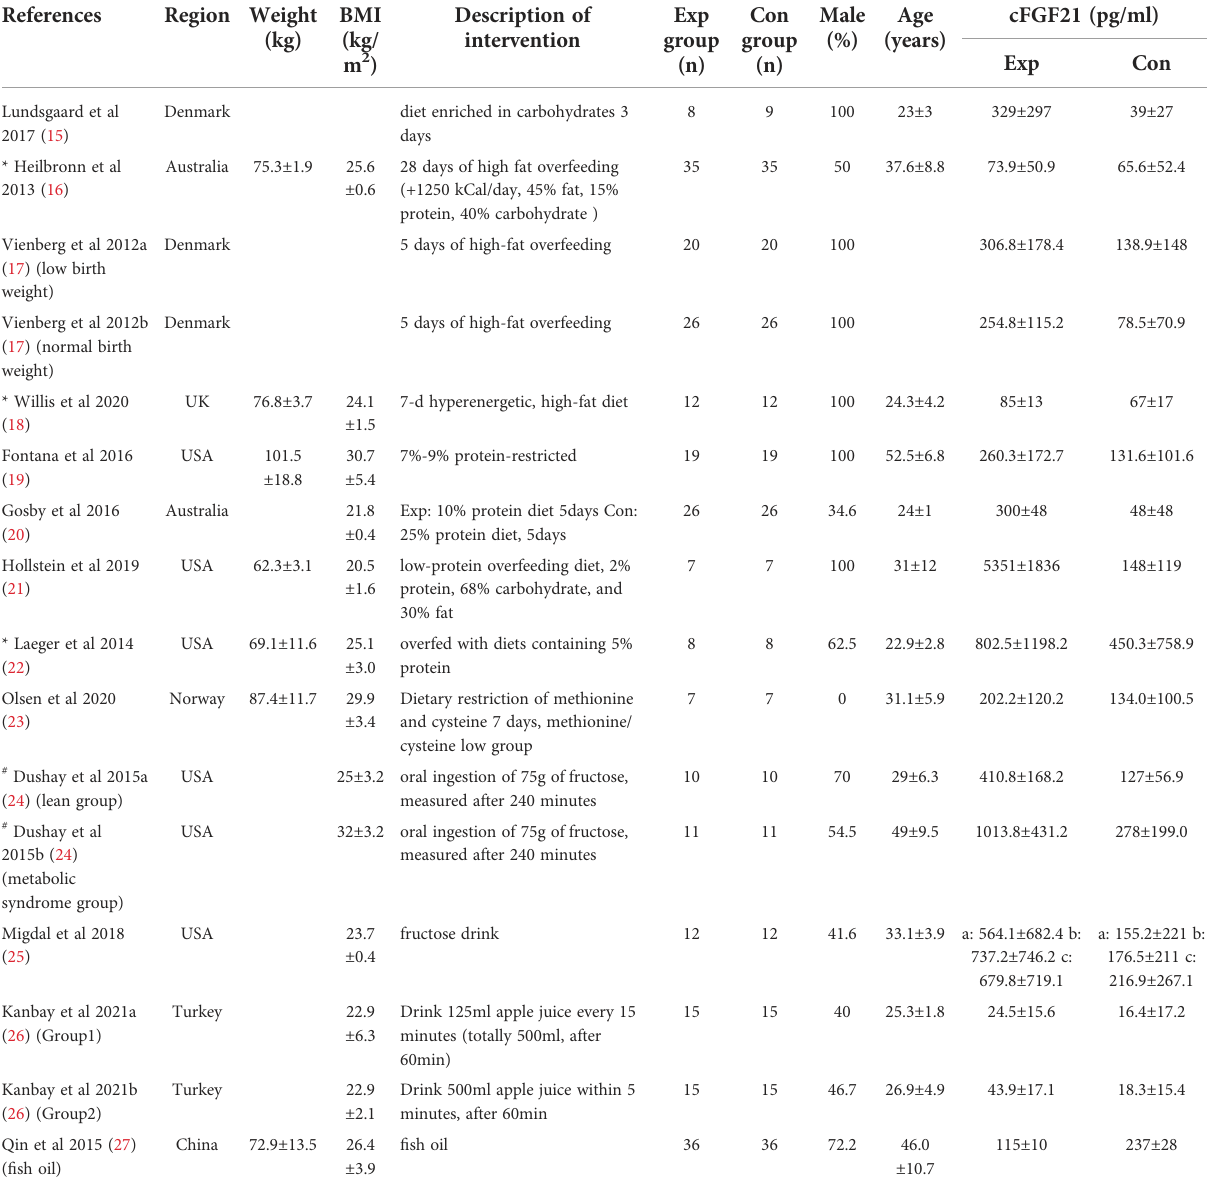
TABLE 2 Baseline characteristics of studies reported cFGF21 concentration in subjects with diet